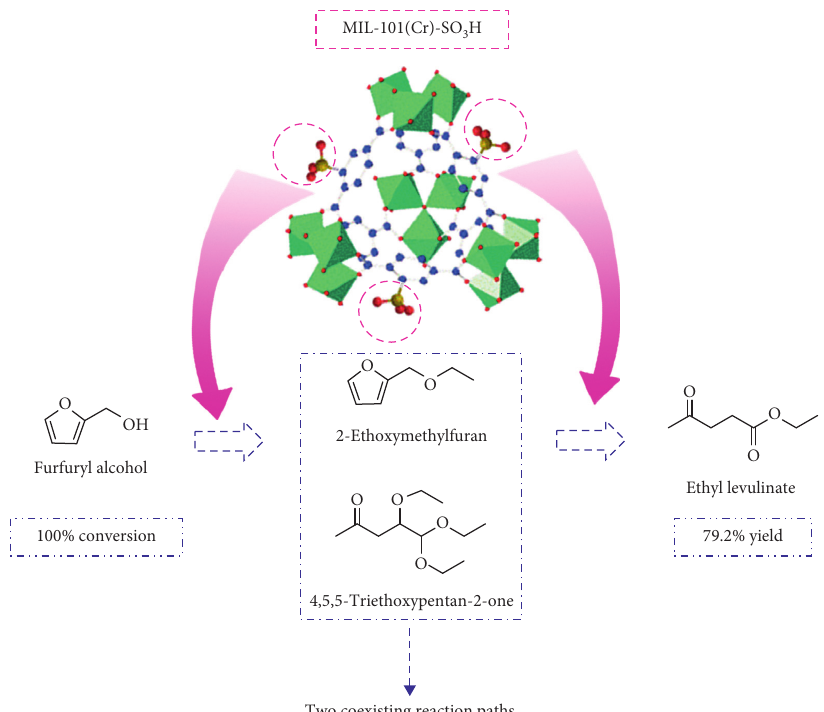
Figure 3: Possible mechanisms for the synthesis of ethyl levulinate from ethanolysis of furfuryl alcohol over